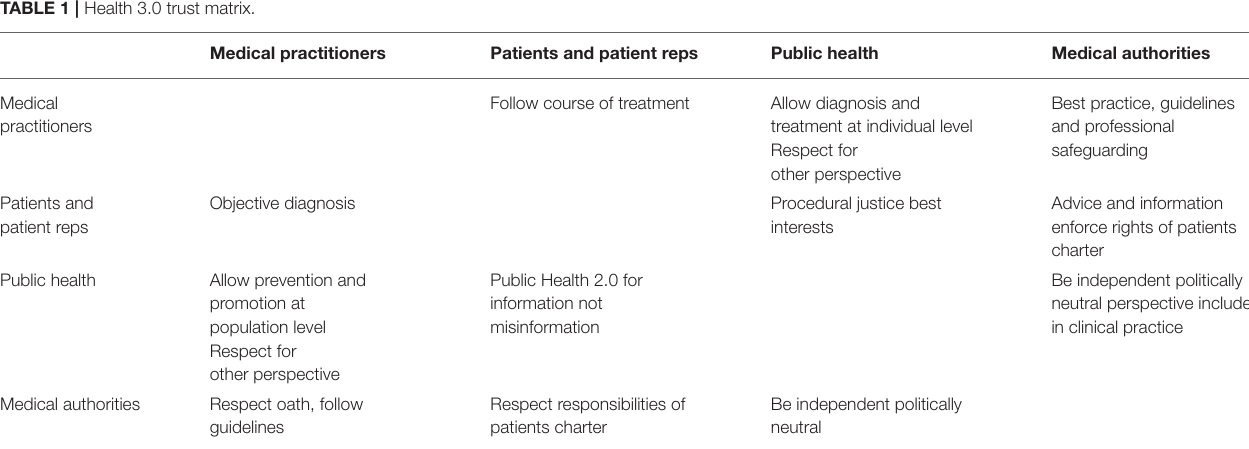
TABLE 1 | Health 3.0 trust